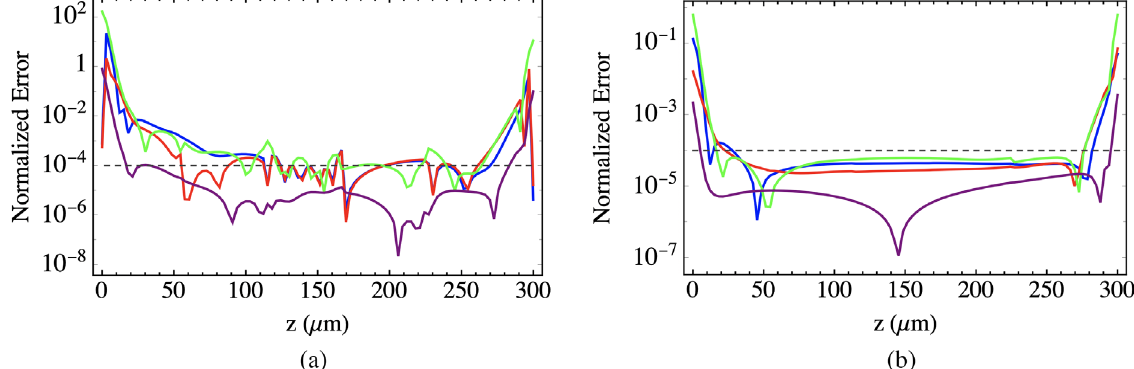
FIG. 6. Normalized error in electric potential (purple line) and field components (blue, red, and green line, respectively) for the electric dipole using 6 × 10 4 boundary elements with Dirichlet (a) and Neumann (b) conditions. The dashed black line represents an error of 10 − 4 for comparison.